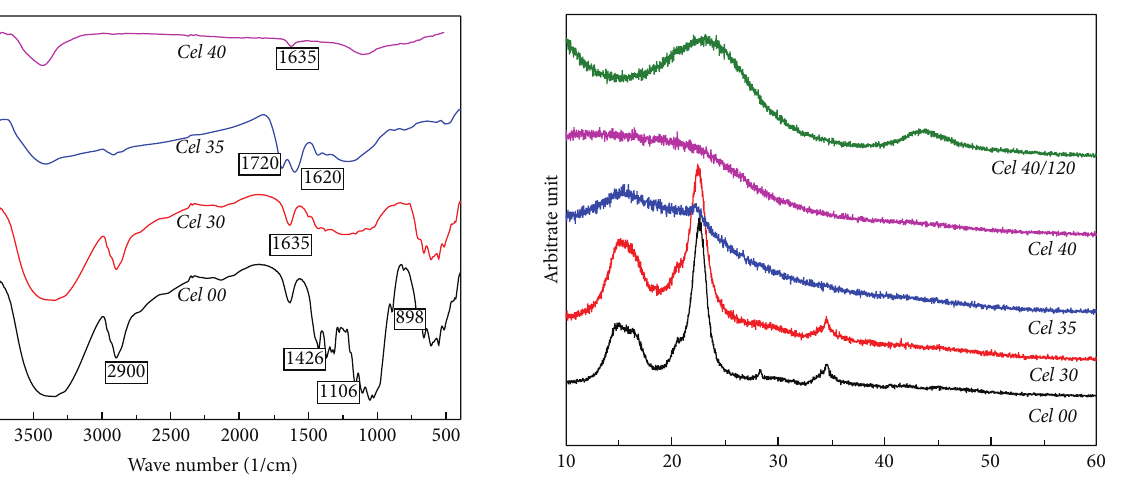
Figure 9: The XRD curves of the cellulose particles based on the heat treatment